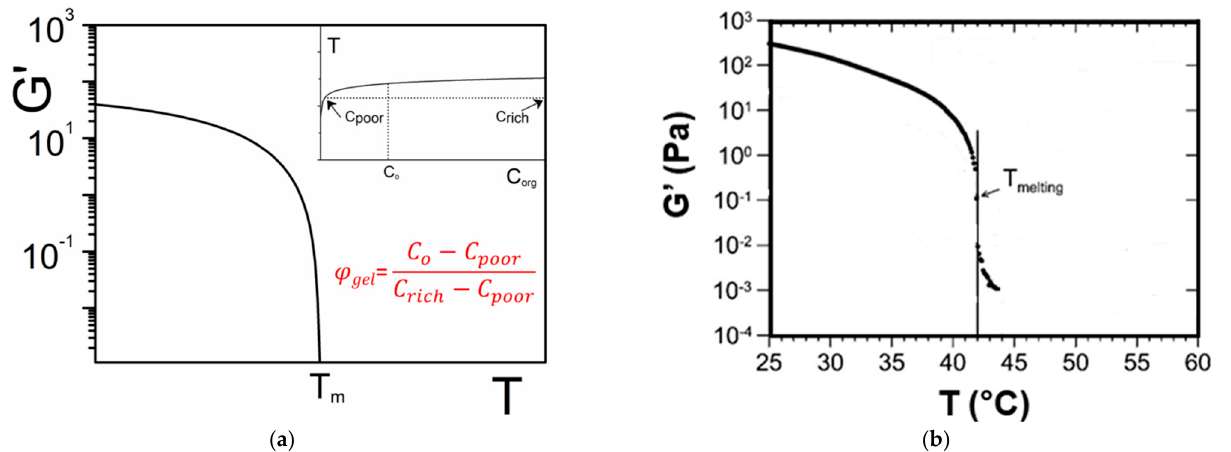
Figure 18. ( a ) theoretical variation of the elastic modulus as a function of temperature. ϕ gel is the gel volume fraction calculated as shown. Inset: the corresponding liquidus used for the calculation of G ′ . ( b ) experimental results obtained by Collin et al. on a peptide-based organogelator in 1,2,3,4-tétrahydronaphthalene Appendix Figure A5 [12].